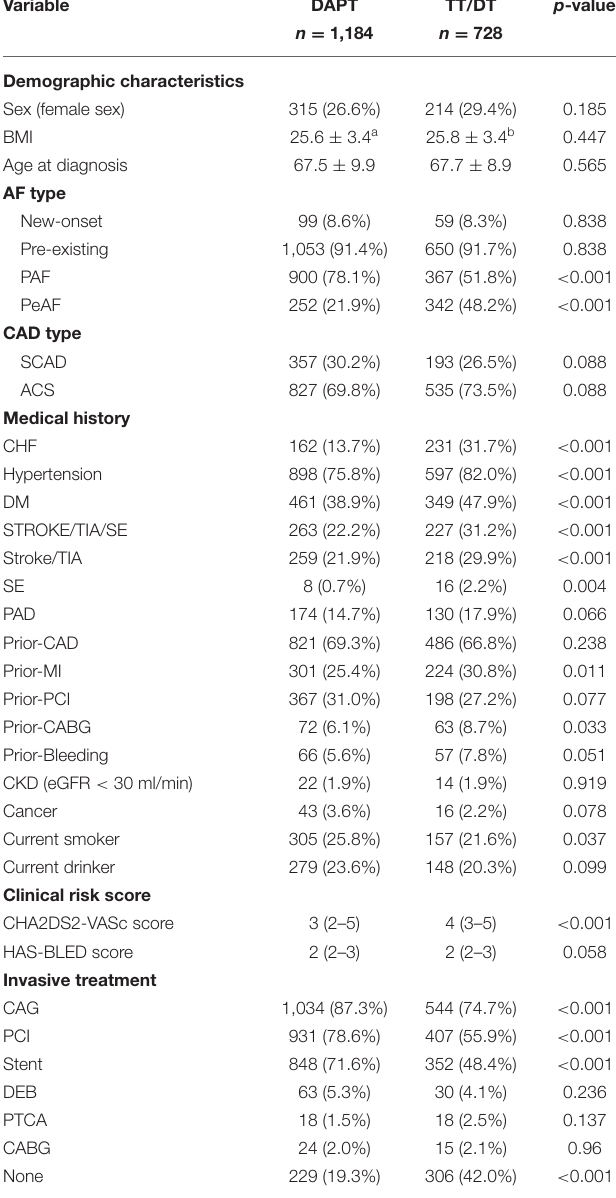
TABLE 3 | Baseline characteristics of patients by DATP or TT/DT treatment type.